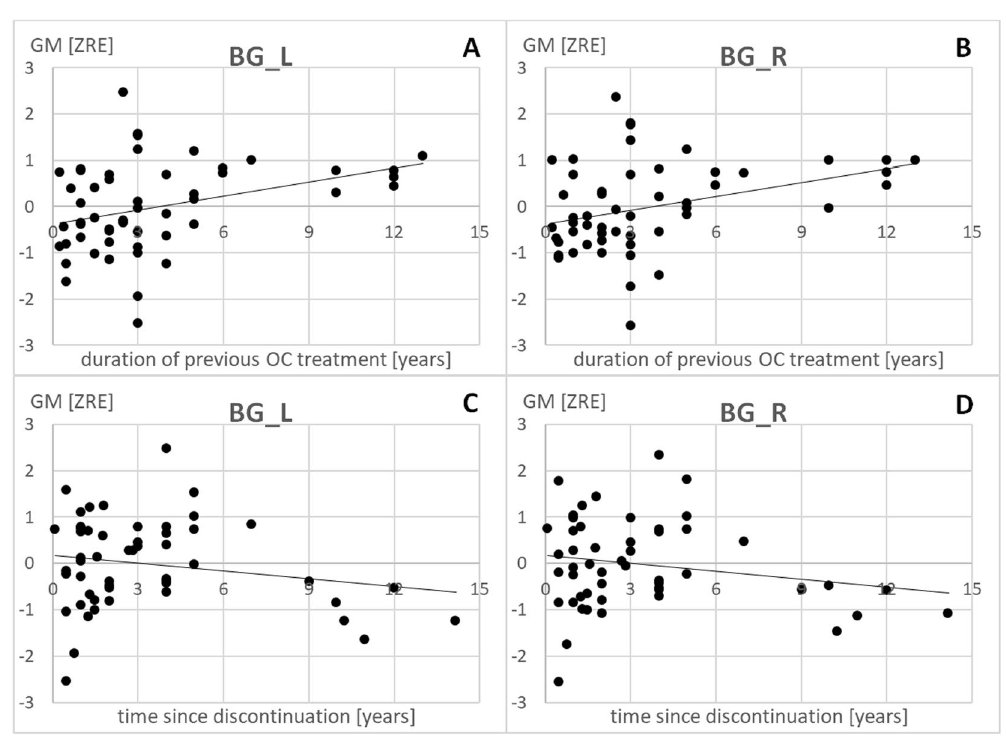
Figure 2. Relationship of previous OC treatment duration and time since discontinuation to gray matter volumes in the left and right basal ganglia (BG). L = left, R = right, ZRE = standardized residual after controlling for age and total intracranial